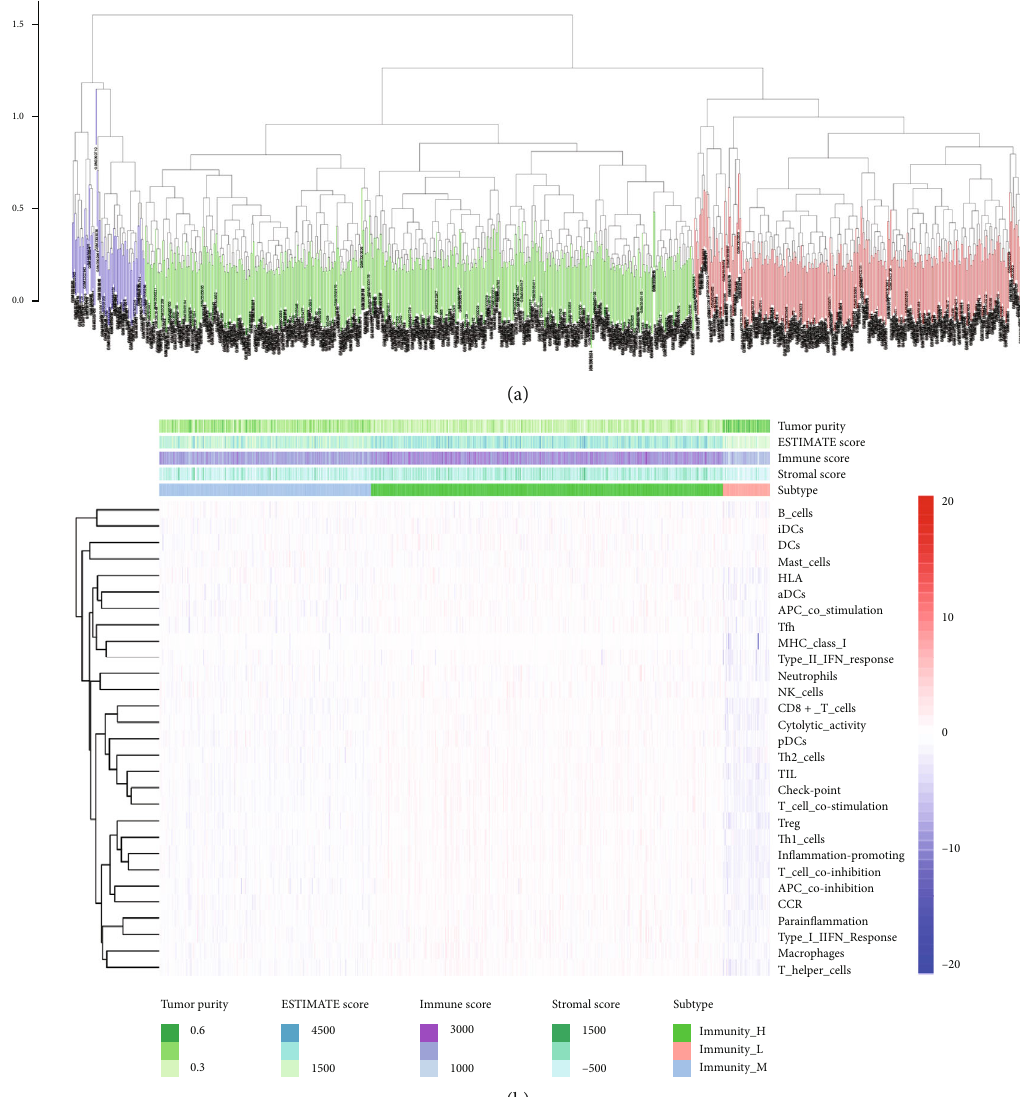
Figure 2: (a) Based on unsupervised cluster analysis of genomic ssGSEA score, 928 DLBCL samples were divided into three groups: Immunity_H ( n = 636 ), Immunity_M ( n = 322 ), and Immunity_L ( n = 71 ). (b) Heat map of Immunity_H, Immunity_M, and Immunity_ L subtypes according to 29 immune cell